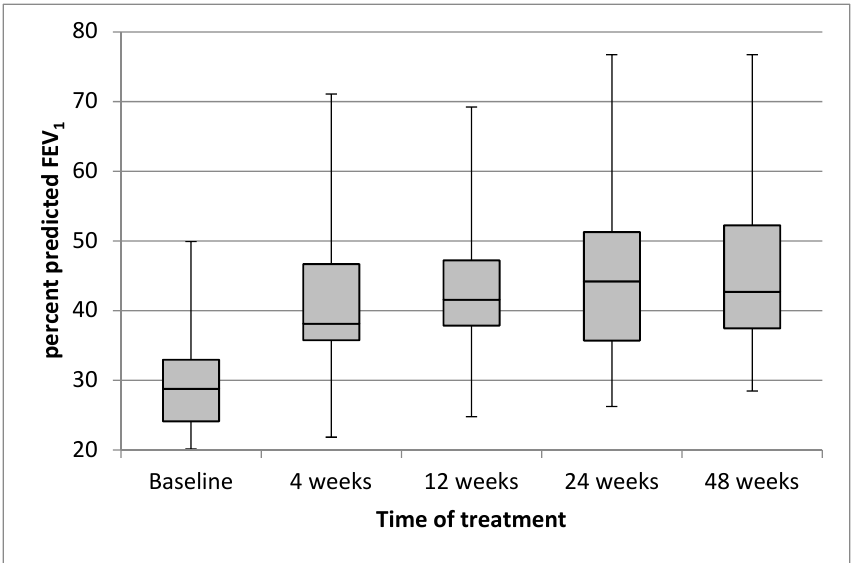
Figure 1. Effect of treatment with elexacaftor/tezacaftor/ivacaftor on percentage of predicted FEV 1 from baseline through to week 48. Each box and whisker plot shows the position of the minimum, lower quartile, median, upper quartile, and maximum of the data, at baseline and at different times of treatment. Table 2. Absolute change of lung function after treatment with ETI over the 48-week period.